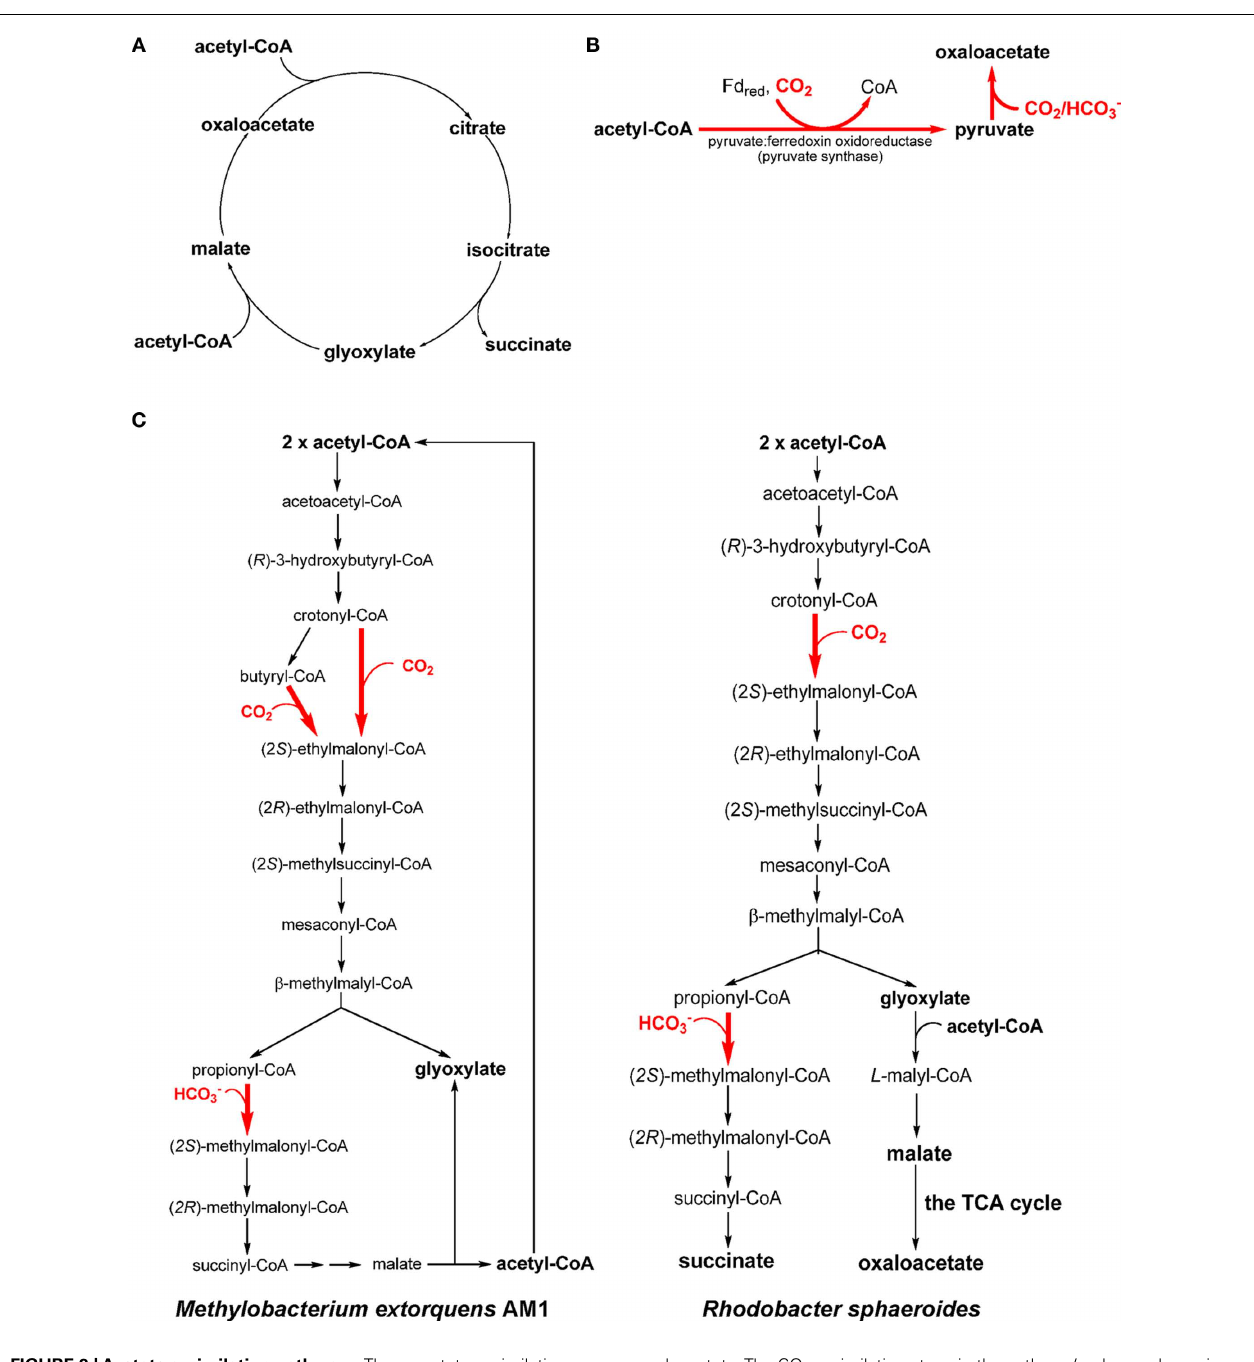
FIGURE 3 |Acetate assimilation pathways. Three acetate assimilation pathways, the (oxidative) glyoxylate cycle (A) , the reaction catalyzed by pyruvate synthase (B) and the ethylmalonyl-CoA pathway (C) , are shown. All of the acetate assimilation pathways may directly or indirectly synthesize